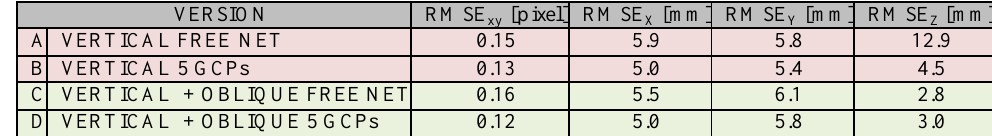
Table 2: Checkpoint RMSEs estimated with different bundle adjustment computations and network configurations (GSD = 3 mm).